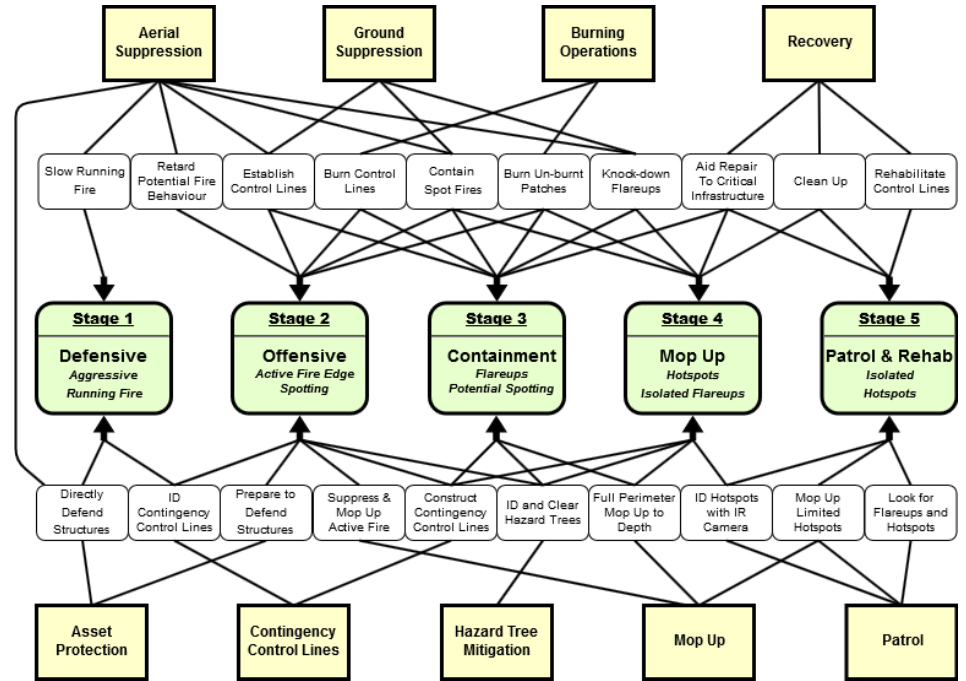
Figure 1. Suppression stages, activities and tasks. Green boxes are stage names and associated key fire behaviour. White boxes are distinct suppression tasks identified by analysing cross-coded broad categories of suppression activities (yellow boxes) with the suppression stages.